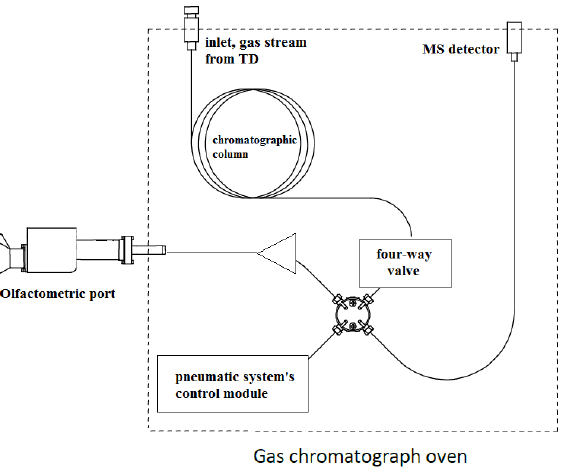
Figure 1. Simplified diagram of the TD – GC – MS/O chromatographic array used for the tests.